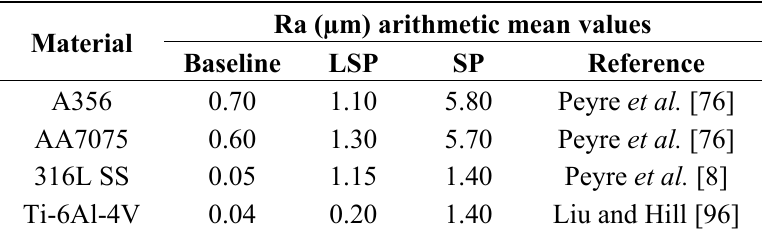
Table 4. Arithmetic mean (Ra) values from different